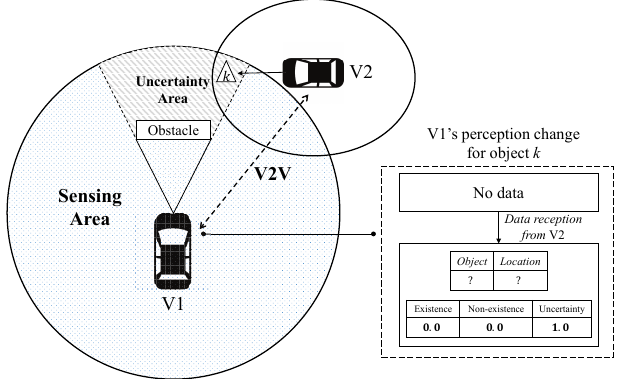
Figure 2. Definitions of sensing and uncertainty areas. The object in uncertainty area can be perceived through V2V